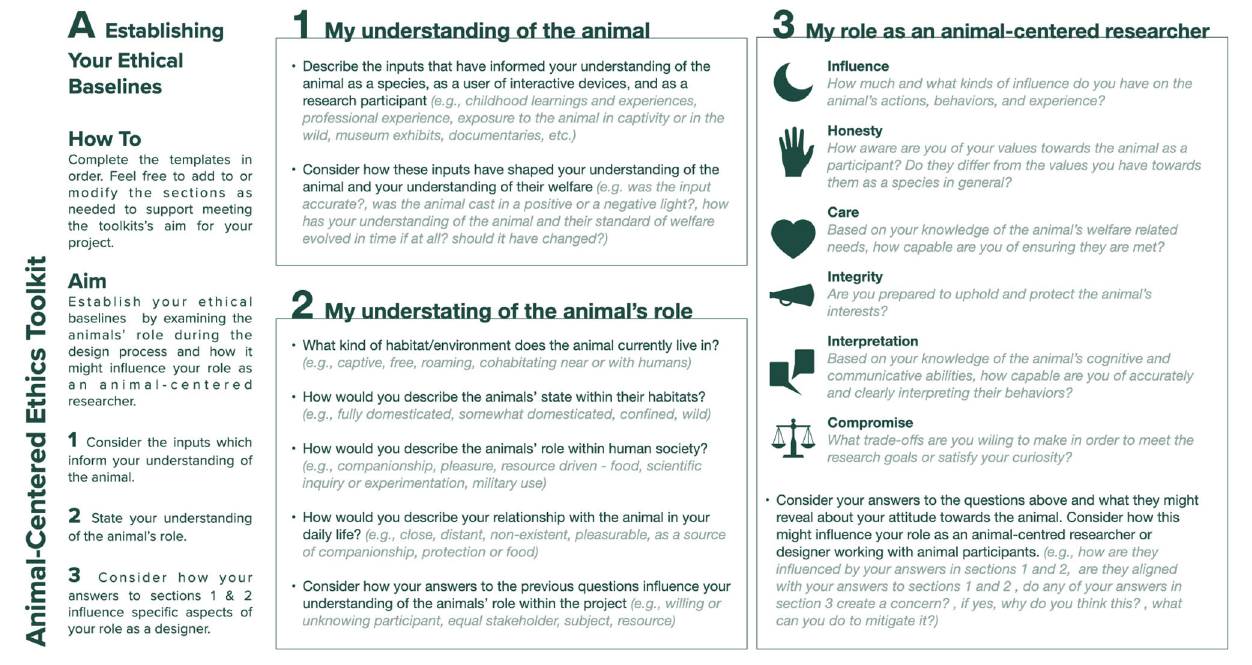
FIGURE 1 | Template A: establishing your ethical